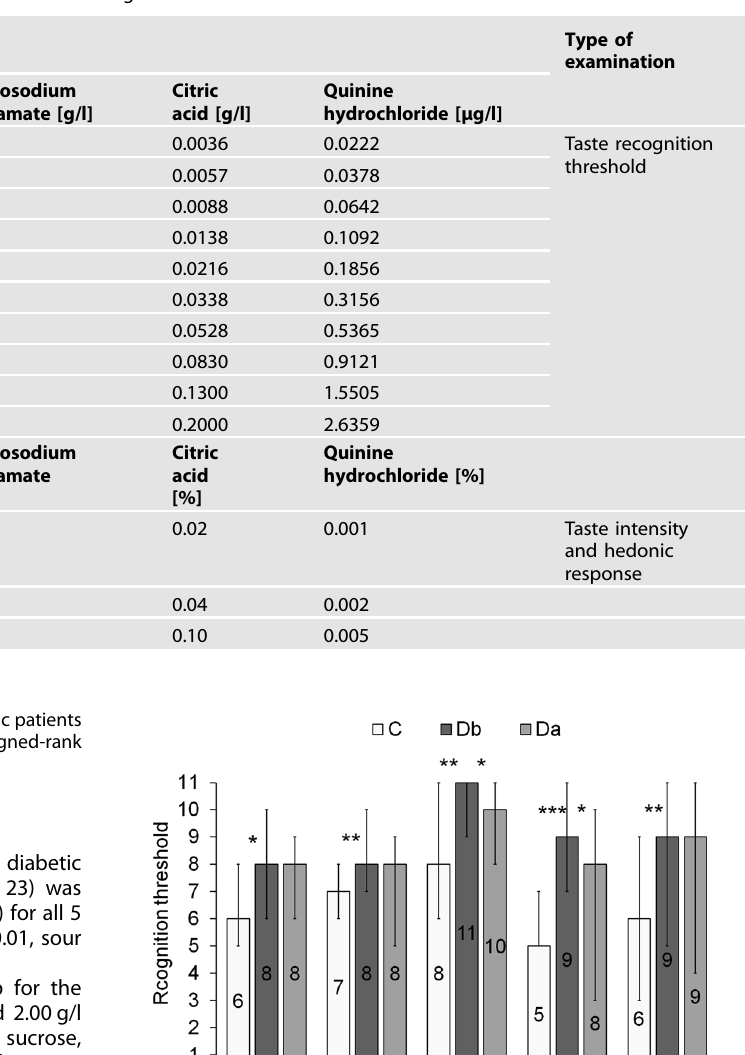
Table 4. Concentrations of taste solutions used for the gustometric investigations.